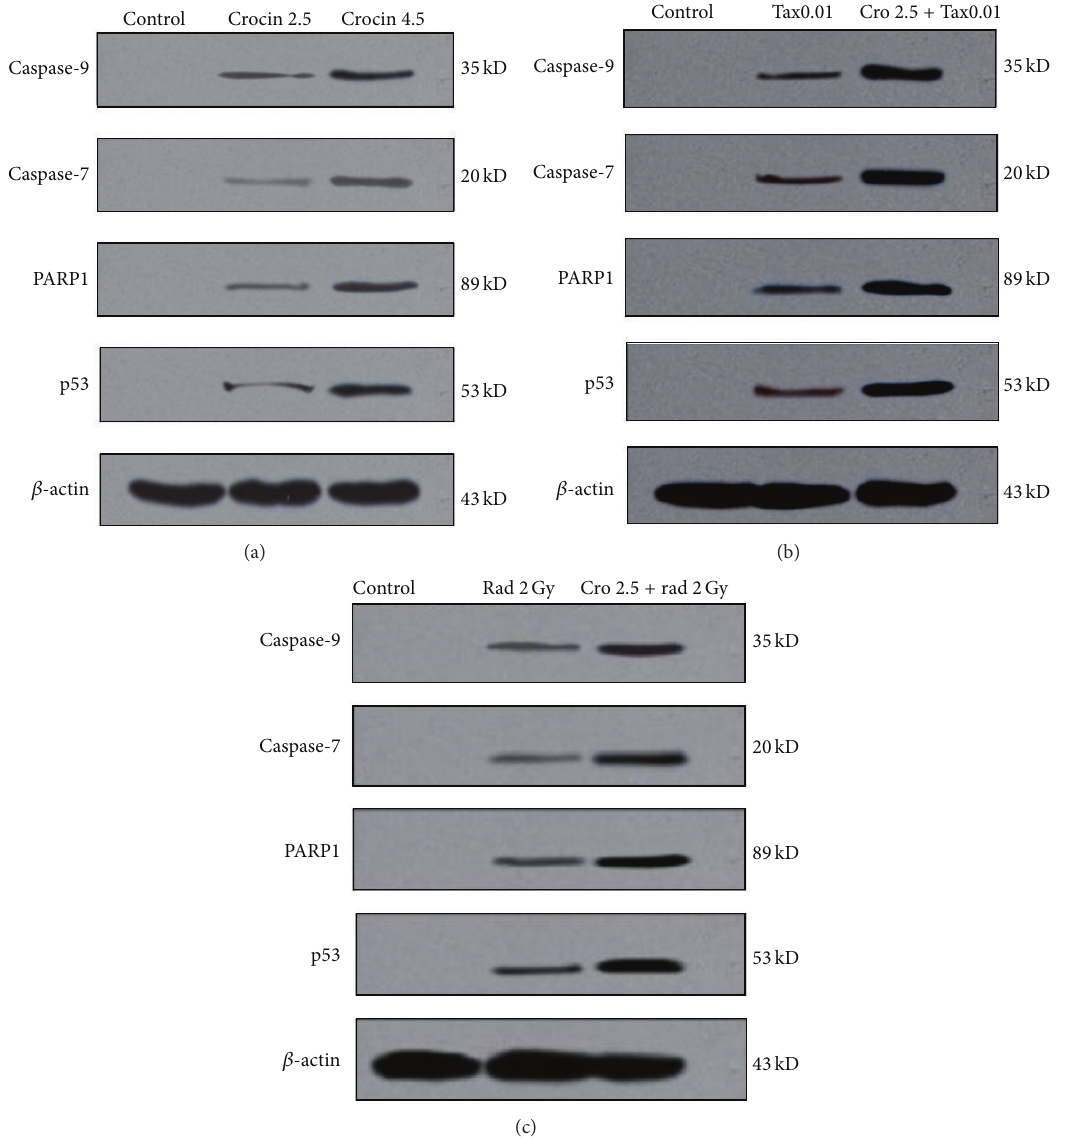
Figure 5: (a) Western blot of cells treated by 2.5 and 4.5 mg/mL of crocin, (b) western blot of cells treated by paclitaxel 0.01 𝜇 m/mL and paclitaxel 0.01 𝜇 m/mL + crocin 2.5 mg/mL, and (c) western blot of 2Gy gamma radiation and 2 Gy + crocin 2.5